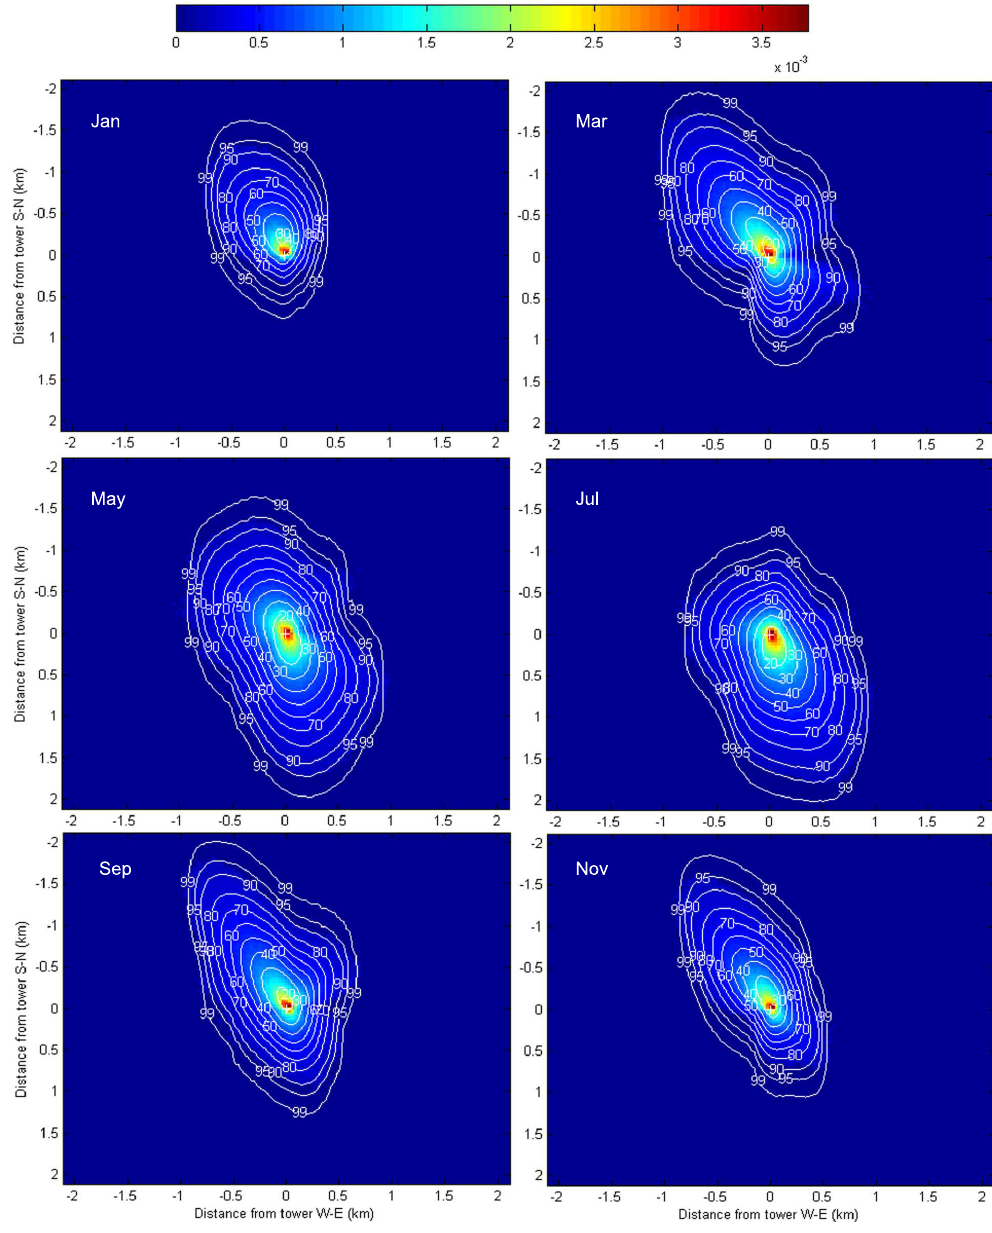
Fig. 4. Mean monthly daytime pure footprints and the corresponding cumulative footprint contours for every other month in 2004 for the QYZ flux tower in an evergreen needleleaf plantation,